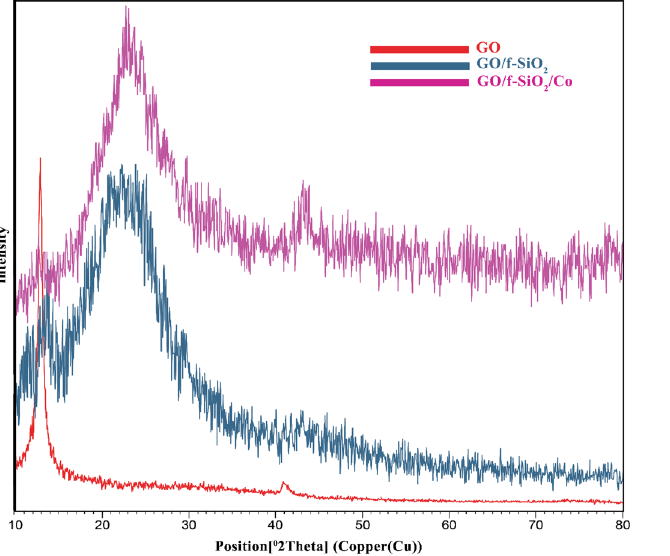
Figure 2. XRD patterns for GO, GO/f-SiO 2 , GO/f-SiO 2 /Co.